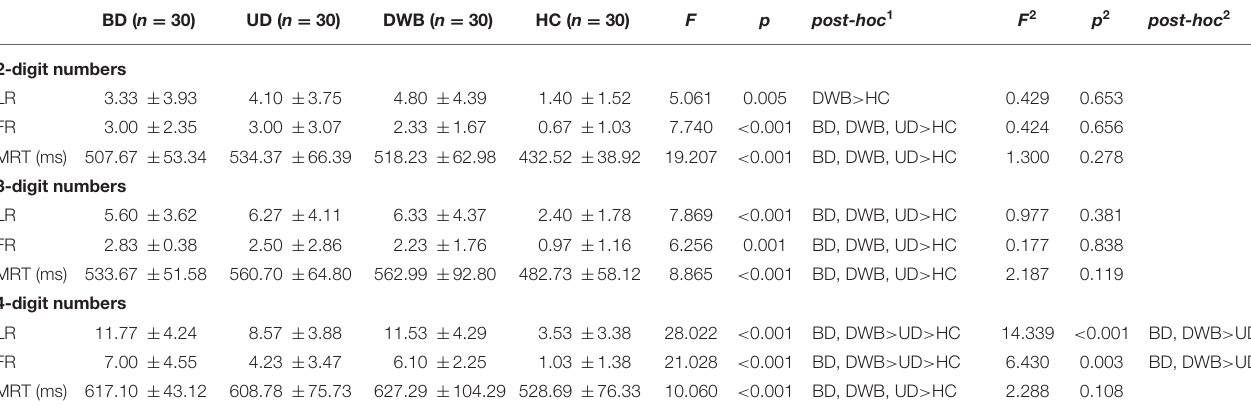
TABLE 4 | Comparison of CPT among patients with bipolar depression, unipolar depression, depression with bipolarity, and healthy controls (mean ± SD). BD ( n =